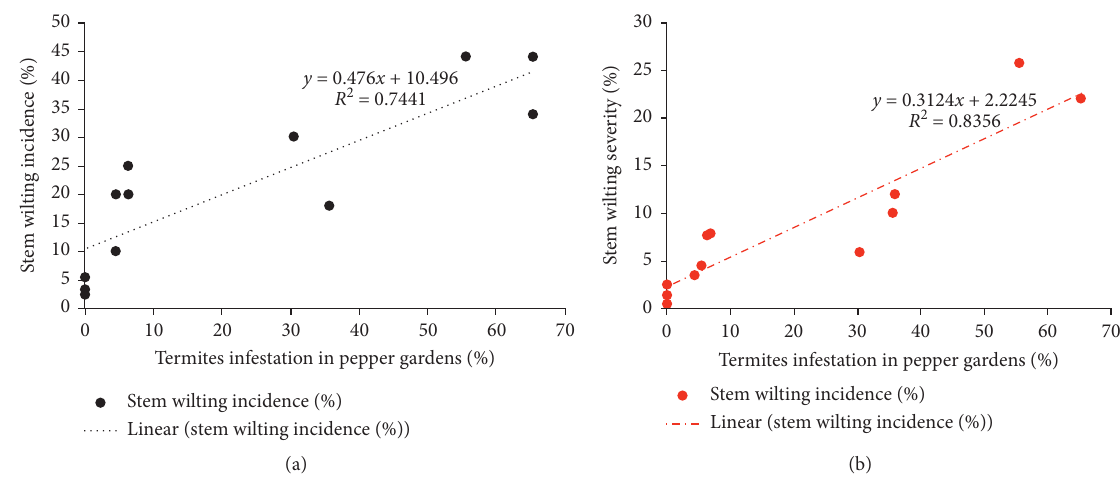
Figure 7: Regression analysis between termite pest infestation and stem wilting incidence (a) and severity (b) on pepper plants.